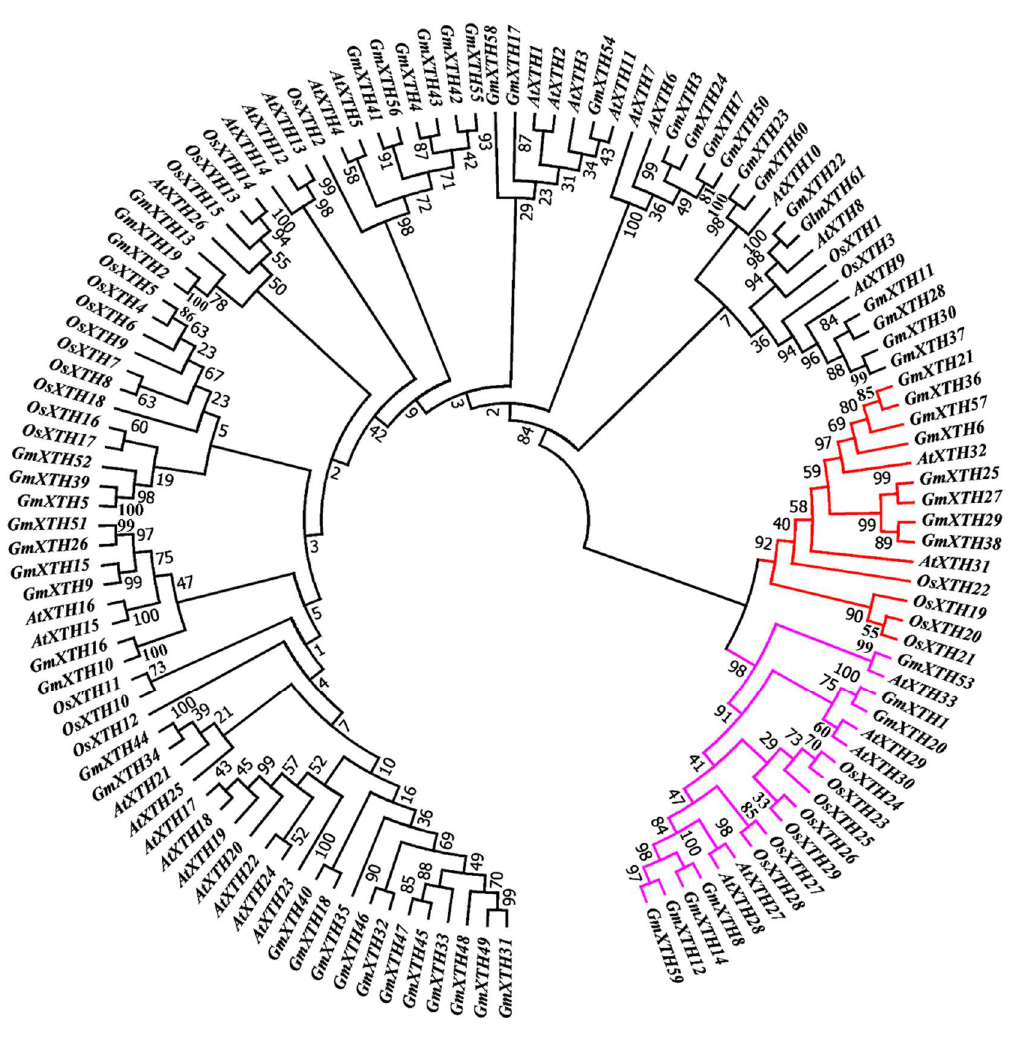
Figure 1. An unrooted phylogenetic tree for AtXTH , OsXTH , and GmXTH genes. A phylogenetic tree was constructed using the neighbor-joining method implemented in MEGA7. The number beside the branches represents bootstrap values based on 1000 replications. The XTH members are classified into three subfamilies. Genes from groups I/II and III are shown in the black and red/pink lines, respectively. Group III was designated group IIIA (red) and group IIIB (pink).